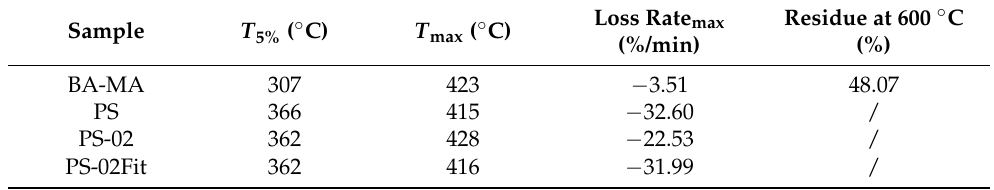
Table 2. Characteristic parameters of TGA and DTG curves for BA-MA, PS, PS-02, and PS-02Fit.